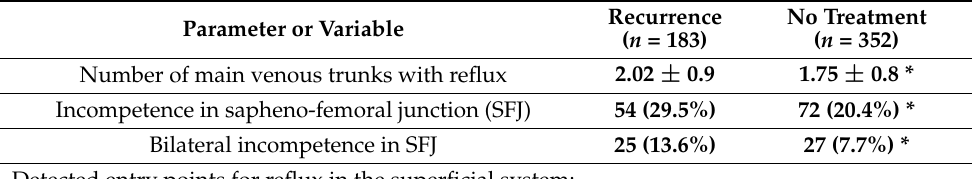
Table 3. The comparison of leg ultrasound examination results. The values shown in the table represent the mean ± SD, or the number (percentage) of patients with corresponding features,